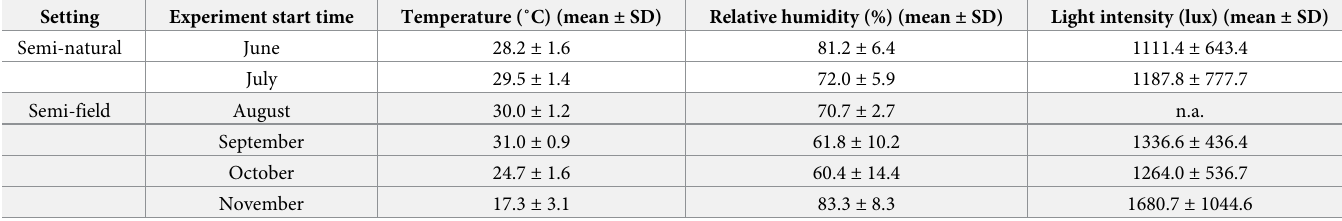
Table 1. Mean air temperature, relative humidity, and light intensity during the larval experiments.